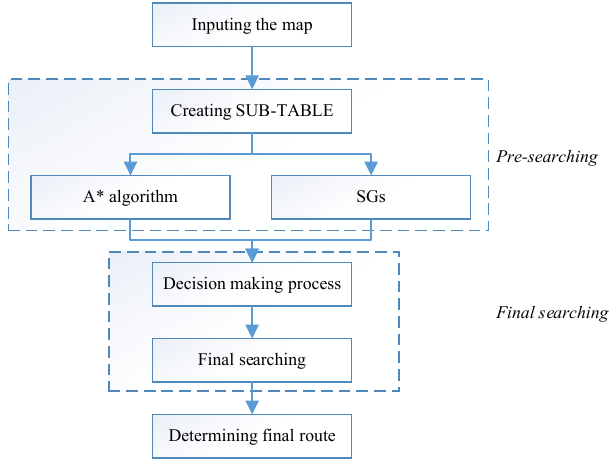
Fig. 1. The flowchart of the proposed hybrid method.